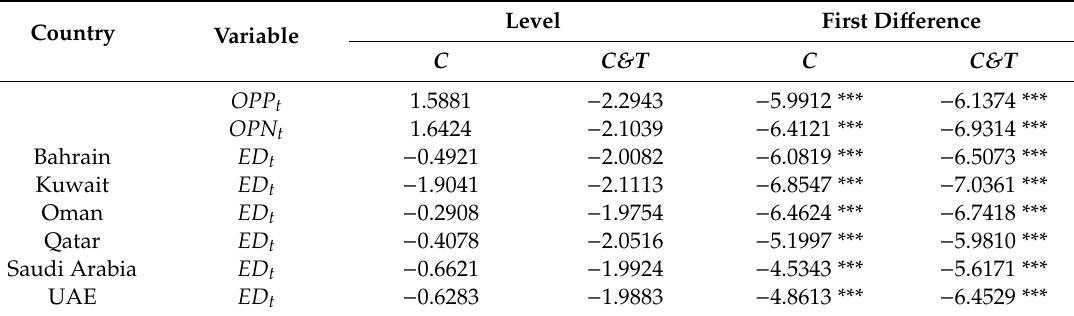
Table 1. Dickey–Fuller generalized least square (DF-GLS) test.